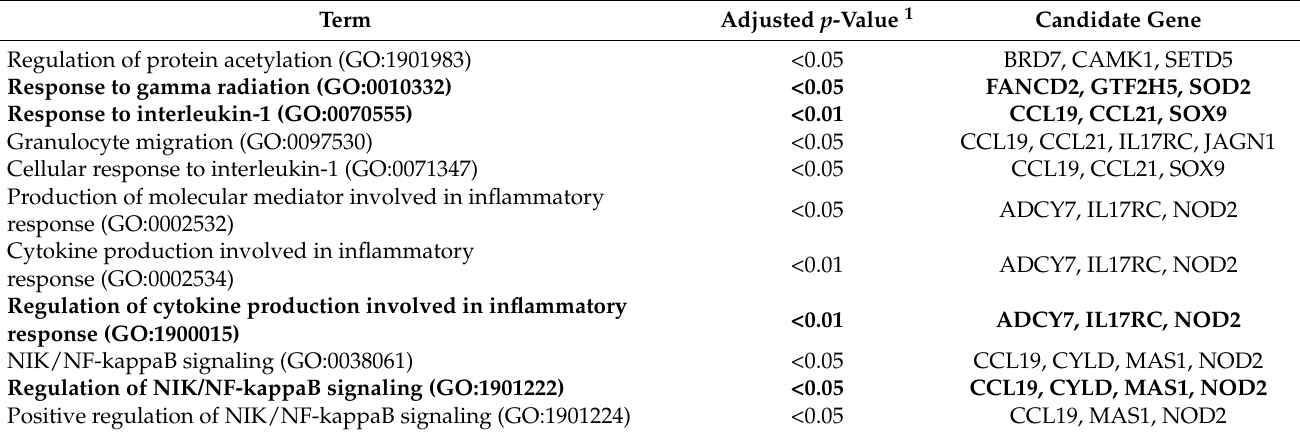
Table 4. Results of GO and KEGG pathway analyses associated with SGE in crossbred